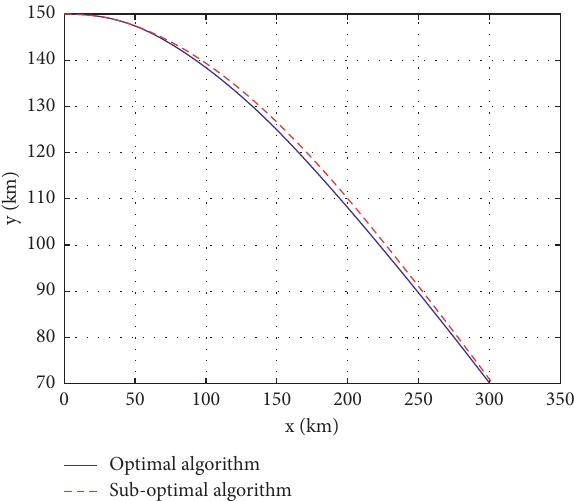
Figure 7: Trajectory curves under different